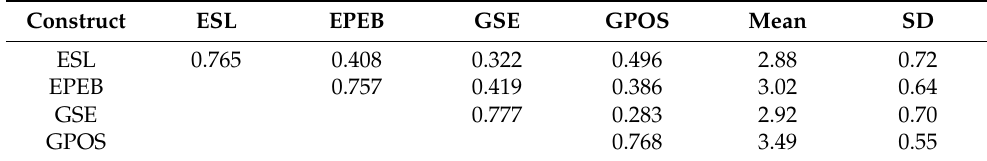
Table 2. Correlations and discriminant validity.